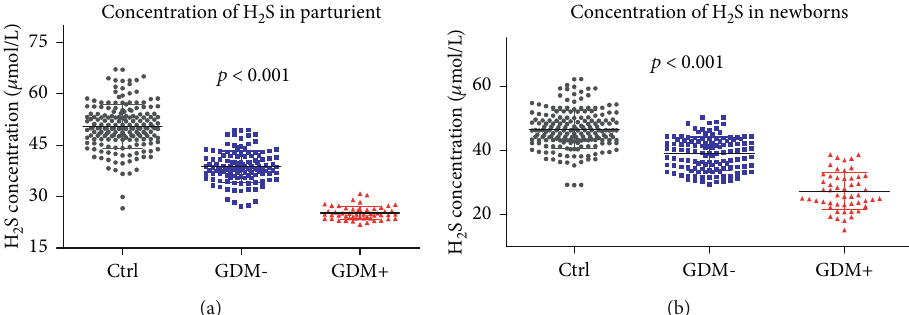
Figure 1: Concentration of H S detected in the venous blood of parturient women and the UVB of newborns. (a) Concentration of H 2 detected in the venous blood of pregnant women was decreased among the control, GDM-, and GDM+ groups. (b) Concentration of H detected in the UVB of newborns was decreased among the control, GDM-, and GDM+